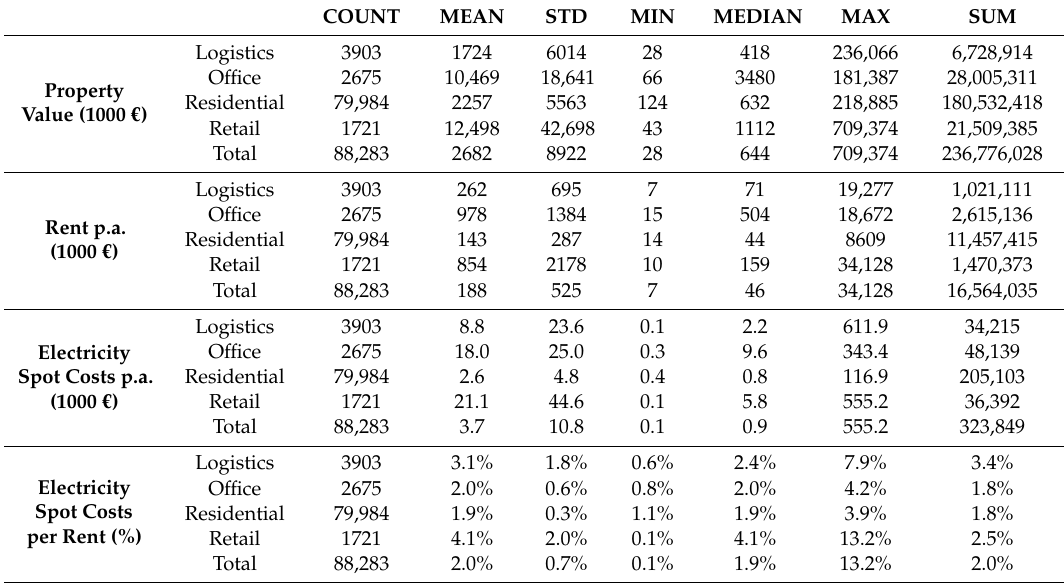
Table 1. Property values, annual rents, annual electricity spot costs and their ratios for the building stock of the HMA. COUNT MEAN STD MIN MEDIAN MAX SUM